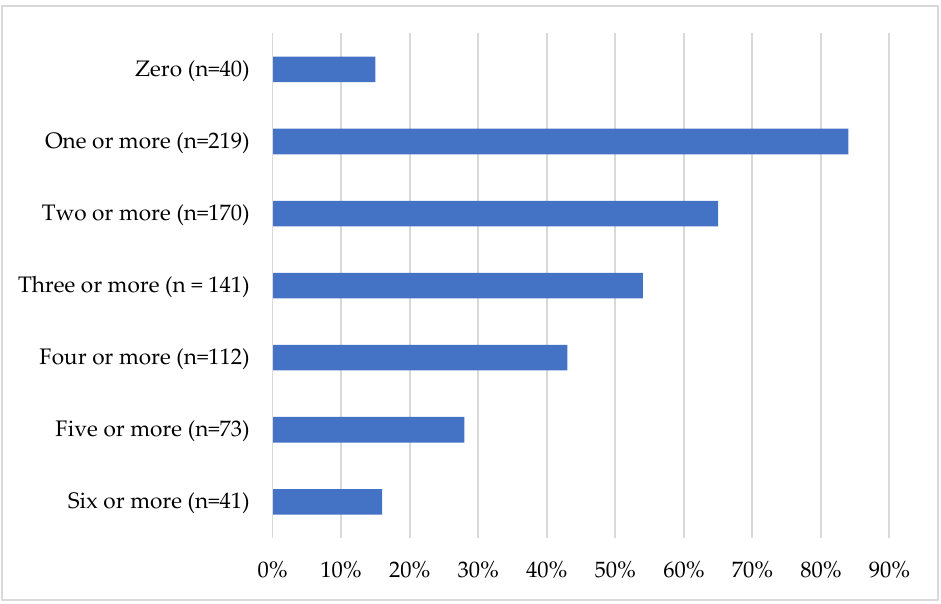
Figure 6. Number of clinically significant symptom areas.